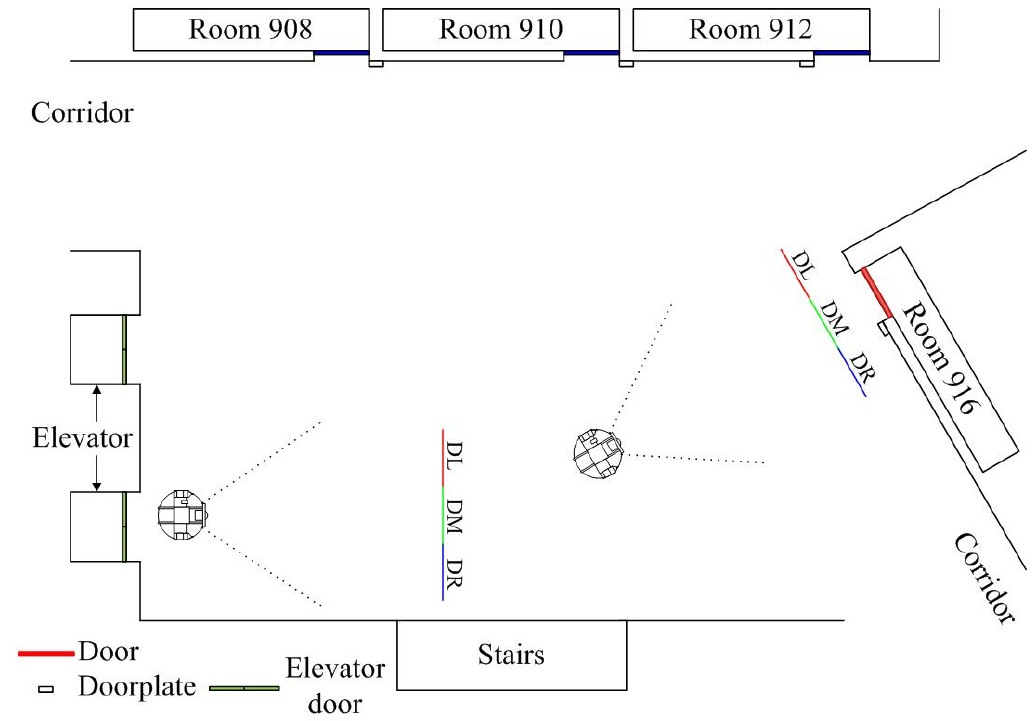
Figure 19. The robot turns left; the DM detects the target; and the robot moves forward to the predefined door.